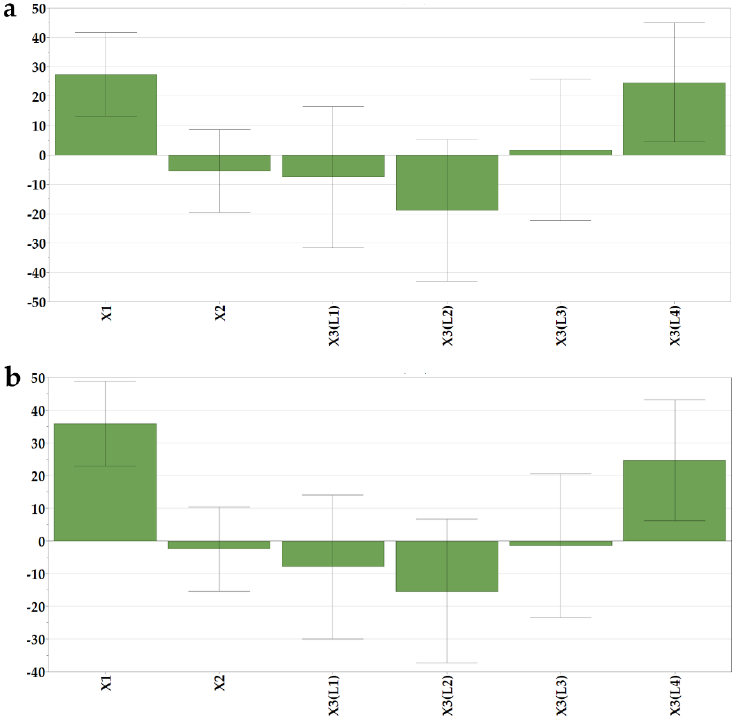
Figure 4. Coefficients of the regression equations displayed as histograms. ( a ) % of dissolved lorata- dine after 5 min (Y5) and ( b ) 10 min (Y6). loratadine after 5 min (Y5) and ( b ) 10 min